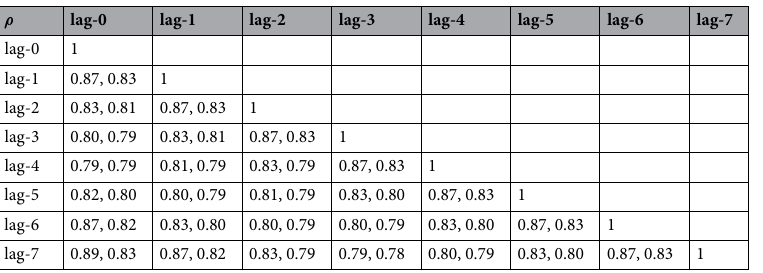
the states. With this lag, the correlations are positive and significant for all states (p-values from 2.98 × 10 − 18 to 1.92 × 10 − 8 ). For the relative humidity, different results preceded ours. A previous study in New York 88 con- cluded that average relative humidity was insignificantly negatively correlated with the daily new cases. It was found that average humidity was significantly negatively correlated and relative humidity was insignificantly negatively correlated with the number of the ICU daily patients, according to data from Milan (14–100% for relative humidity, 1–23 g m − 3 for average humidity), Florence (10% to 100% for relative humidity, 1 to 23 g m − 3 for average humidity) and Trento (16–100% for relative humidity, 1 to 25 g m − 3 for average humidity) in Italy 90 . Data from Brazil ranging from 69.5 to 90.8% with no lag 50,57 showed that the correlation was positive but not significant with minimum and maximum average humidity. Data from 127 countries 87 led to the conclusion that the relative humidity was correlated negatively and insignificantly with daily new cases. Table 1 shows the case-specific auto-correlations. Generally, Pearson is higher than Spearman-rank correlation coefficient. In addition, both Pearson and Spearman-rank correlation coefficient are significant with minimum 0.78 (p-values ≃ 0 ). From the column of lag-0, the auto-correlation generally swings from a large value at lag-1, then minima at either lag-3 or lag-4, to another large value at lag-7. The same behavior can be observed from the columns lag-1 until lag-3 where decrement rules out the first 4 lags and minima were found at either lag 3 or 4 days from the time series. This finding will set a basis for those in the panel regression models, as seen shortly. Spatial auto‑correlation. Meanwhile previous studies much focused on aggregated data and variation of distances in the spatial weight matrix, this study computed the global Moran’s I and Geary’s C for all time to see how the spatial pattern changes seasonally since the earliest infection. The corresponding computation V ( I ) , I + 1.93 V ( I ) ] (respectively for C ) are results together with the 95% confidence interval [ I − 1.93 (cid:31) (cid:31) presented in Fig. 5. Although the spatial pattern of the daily cases in all the states changes around with time, it is evident that randomness overwhelms the pattern for most of the time. The progression of p-values (especially below α ) indicates that, generally, no significant difference between Moran’s I and Geary’s C was observed except on the duration from November until mid of December where Geary’s C shows more locally clustered spatial pattern. The Moran’s scatter plot for all the states in Germany was determined for all observations, see Fig. 6. For the sake of serial presentation, indexing the coordinates based on the quadrants is more favorable than plotting them. Overall, the results suggest that all the states show randomness with time in to which spatial pattern they belong. If one solely focuses on the recent observations (November 1 to December 15, 2020), then the following states have the tendency to occupy the following quadrants: Baden-Württemberg, Bavaria, Hesse, Thuringia (Q1); Brandenburg, Rhineland-Palatinate, Saxony-Anhalt (Q2); Hamburg, Mecklenburg-Vorpommern, Lower Saxony, Schleswig-Holstein (Q3); Berlin, Bremen, North Rhine-Westphalia, Saxony (Q4). Panel regression models. Variable choices for model specification were investigated. The criteria are based on not only fit and complexity (information-type criterion) but also insignificance, negative marginal effects, and multicollinearity driven by certain variables. For the fit and complexity, a minimal value of Bayes- ian Information Criterion BIC = − 2log ( L ) + log ( N ) · k 91 was sought. The first term of this criterion expresses maximization over the likelihood function L generated from our model and the second term includes the obser- vation size N as well as the number of parameters k . Unlike Akaike Information Criterion (AIC) 92 that would have replaced log ( N ) by 2, BIC penalizes the number of parameters much more, especially for large observation sizes. Our study aims to drop certain variables toward cutting down BIC and amending insignificance as well as multicollinearity. The standard t -test was used for the significance test. Checking for multicollinearity follows from computing the Inverse Variance Inflation Factor (1/VIF) values for all explanatory variables except the con- stant. A 1/VIF measures one minus the coefficient of determination derived from an OLS-regression whereby the variable under test serves as the response while the others as the explanatory variables. In this sense, 1/VIF of a value smaller than the rule of thumb 0.1 shows multicollinearity driven by the tested variable 93 . In addition, the p-value of the F -statistic is monitored, which measures if the overall variables are simultaneously significant; of which smaller than α = 0.05 indicates that they are. Not only can the model be designated to be better than just a constant, but multicollinearity can also be diagnosed. Johnston in 94 hinted the existence of multicollinearity as some p-values from t -tests are large while that from F -test is radically small, which agrees to the analytical inves-